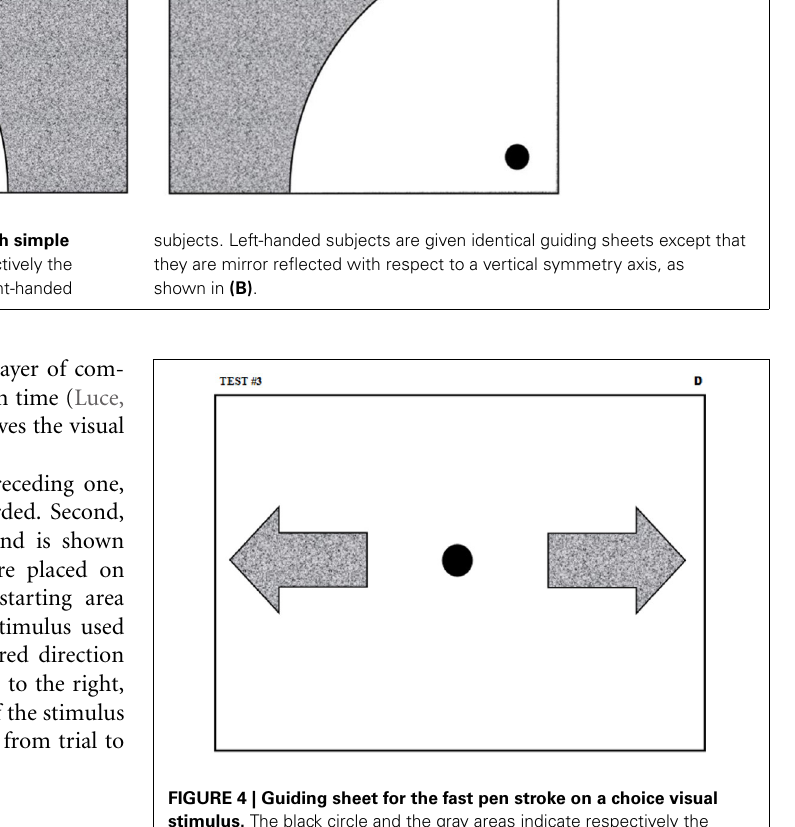
FIGURE 4 | Guiding sheet for the fast pen stroke on a choice visual stimulus. The black circle and the gray areas indicate respectively the starting and the target